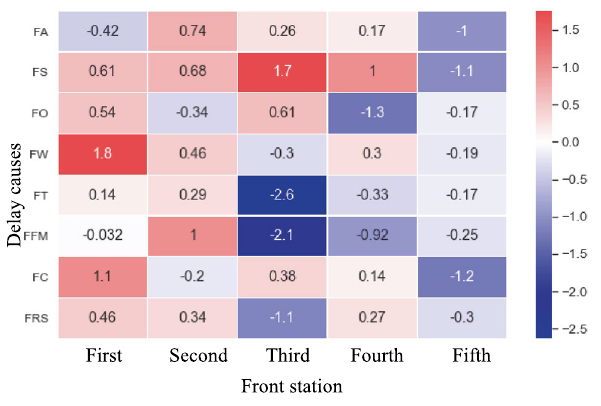
Fig. 3 Average variation of delay status of the train 5 following sta- tions under different causes